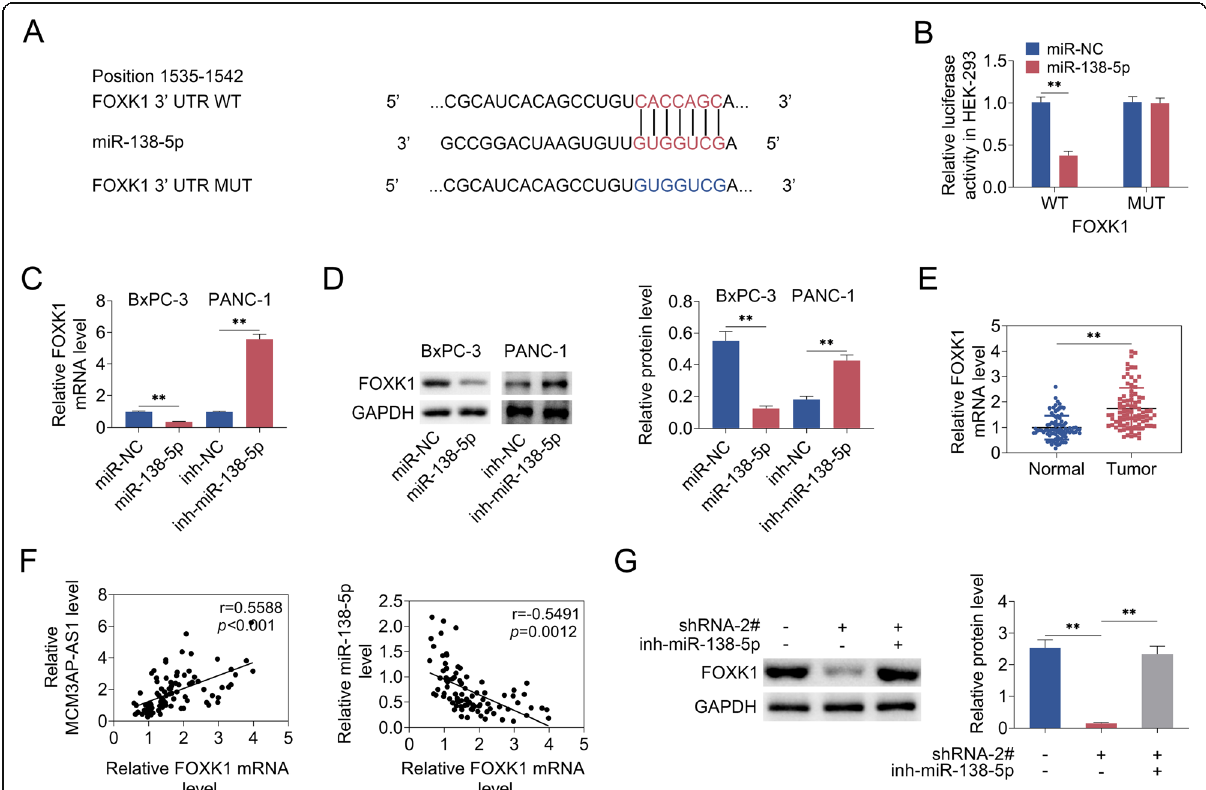
Fig. 5 MCM3AP-AS1 promoted FOXK1 expression by targeting miR-138-5p. a Bioinformatic analysis predicted that miR-138-5p could target FOXK1. b Dual luciferase reporter assay confirmed the relationship between miR-138-5p and FOXK1. c qRT-PCR detected miR-138-5p level. d - f qRT-PCR and western blot analysis measured FOXK1 level. g The correlation between miR-138-5p and FOXK1 was identified. (H) FOXK1 level was examined using quantitative real time PCR and western blot analysis. n = 3. (**, p <